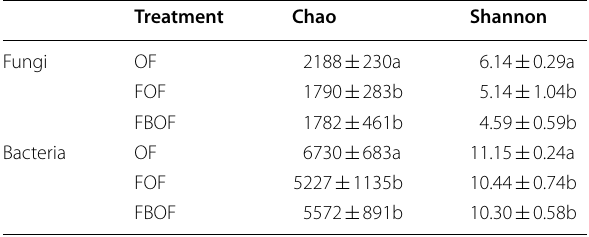
Values are means standard deviation (n 8). Different lowercases indicate a ± = significant difference among all treatments ( P < 0.05; Duncan test) OF organic fertilizer, FOF dazomet fumigation coupled with organic fertilizer, FBOF dazomet fumigation coupled with biological organic